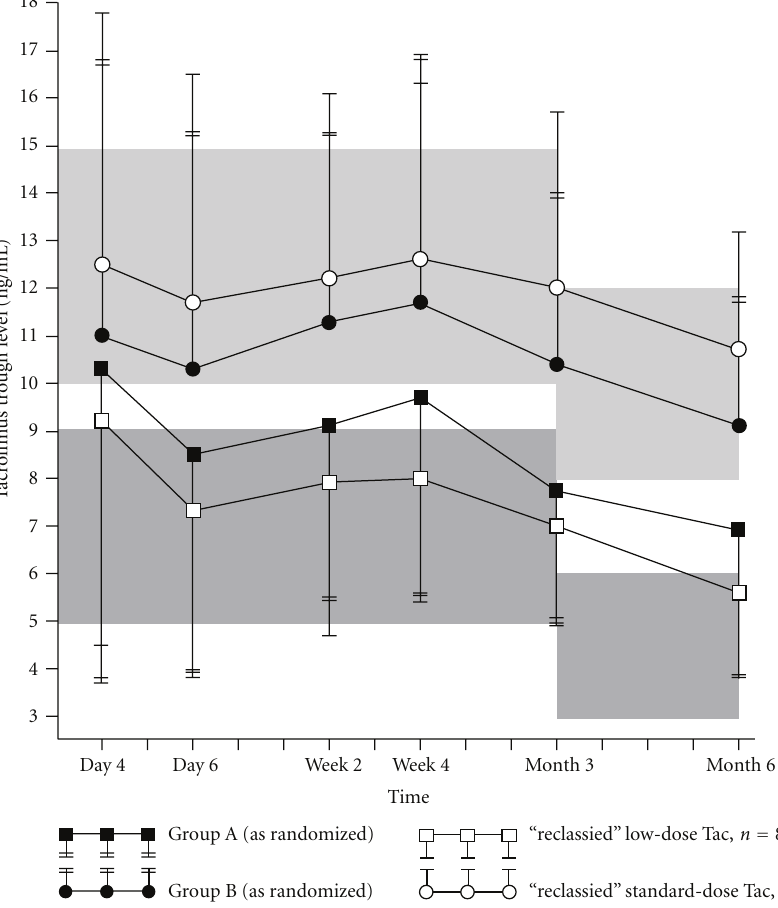
Figure 1: Mean tacrolimus trough levels over time. Tac = tacrolimus; Group A = low-dose tacrolimus ( n = 151); Group B = standard-dose tacrolimus ( n = 141); “reclassified” defined as > 50% of Tac levels (mandatory requirement for month 6 assessment) being within a protocol- specified Tac target range. Bars represent one standard deviation. Shaded areas represent protocol specified target ranges for